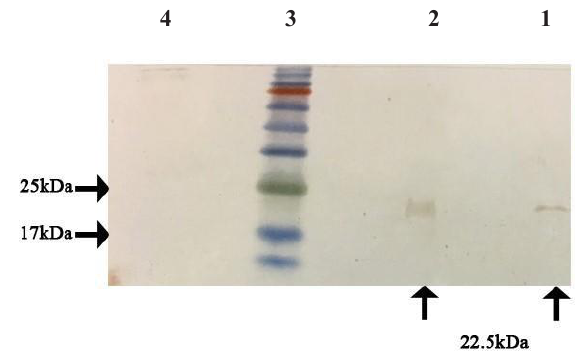
Figure 8. Western blotting analysis of hIFN β -1a protein expression. Line 1: Sample containing supernatant of cells transfected without chemicals. Line 2: Sample containing the supernatant of transfected cells treated with chemicals. Line 3: Prestained protein ladder. Line 4: Negative Control.